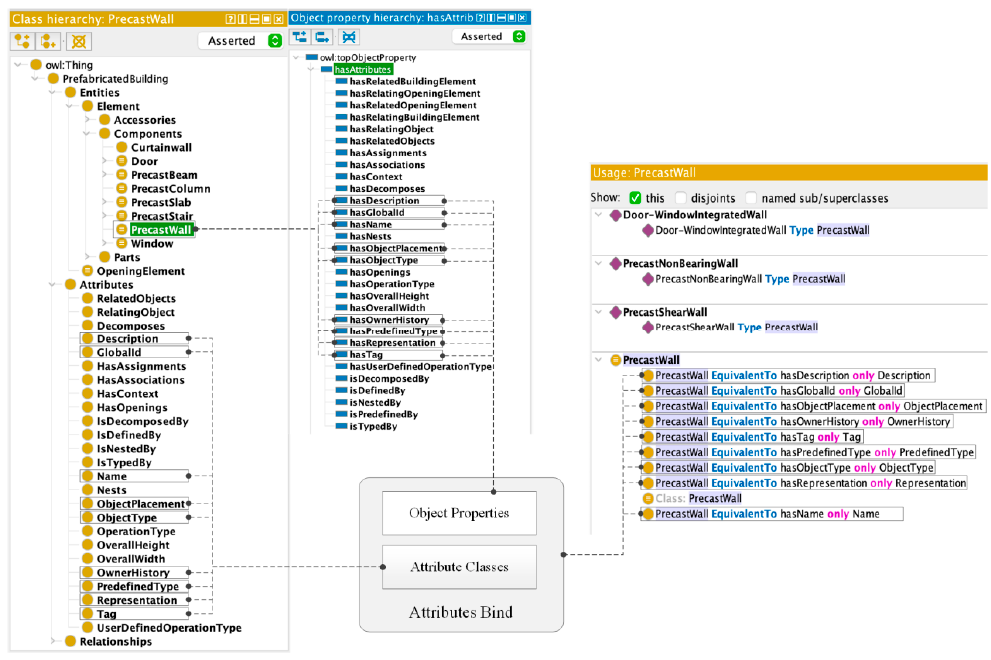
Figure 11. Relationship between prefabricated wall class and attribute classes through object prop- erties.